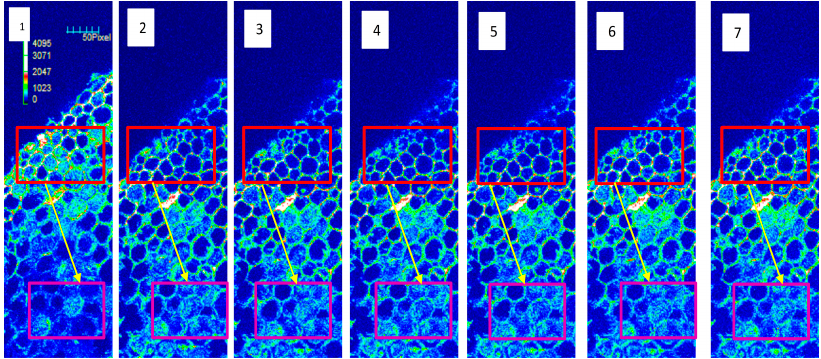
Figure 3. Effect of NPPB on the Ca 2+ signal in tea root mature zone cells. 3D Ca 2+ pseudo-color images in tea root mature zone cells in the absence of NPPB ( 1 ) and presence of NPPB treatment ( 2 – 7 ); Lanes 2 to 7 represent 3D Ca 2+ pseudocolor images of tea roots cells at 2, 4, 6, 8, 10, and 12 min after NPPB